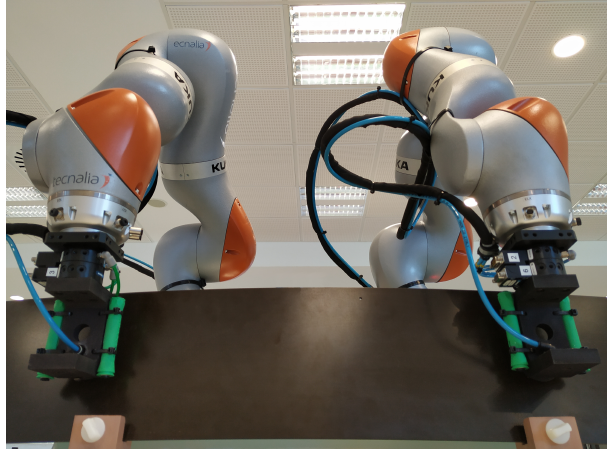
Figure 6. Set-up with two Kuka LBR iiwa